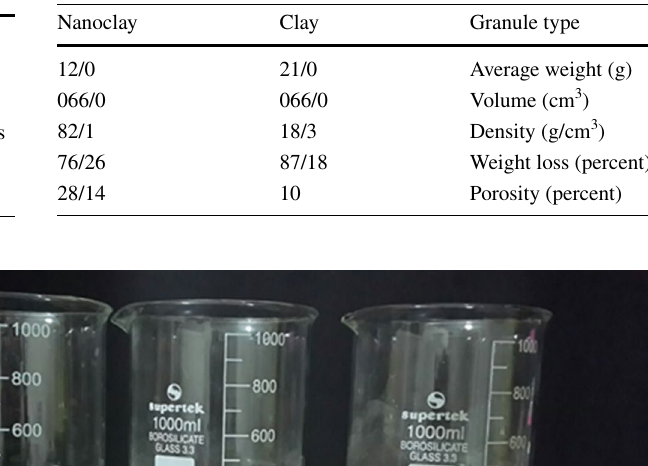
Table 2 Comparison of physical features between clay and nanoclay